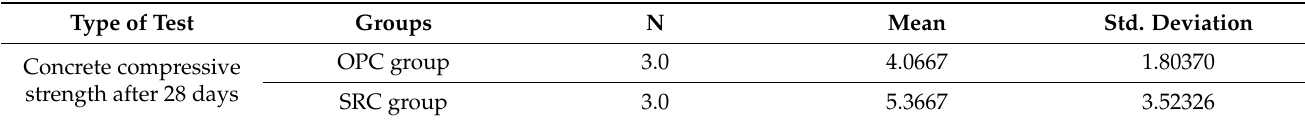
Table 12. Group statistics for concrete compressive strength test after 28 days.